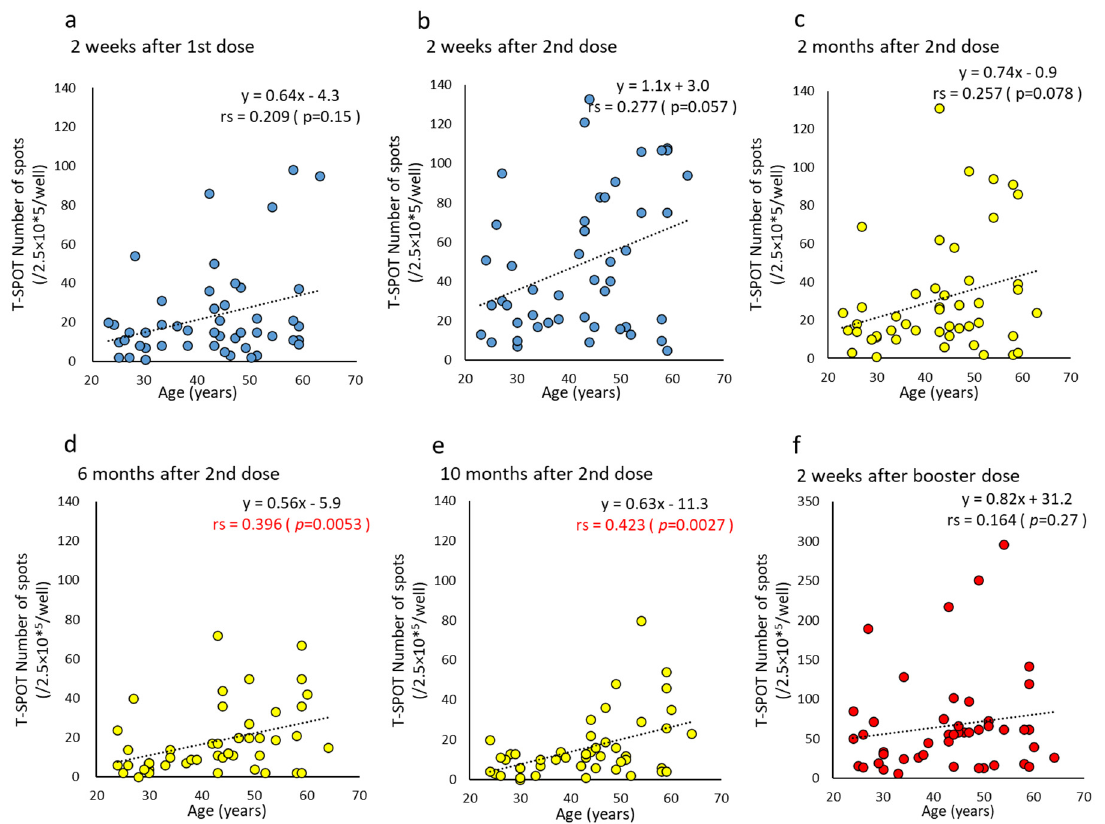
Figure 8. ( a – f ). Correlation at time points between age and T-SPOT after BNT162b2 vaccine doses. Parameter levels indicating T-SPOT of cell-mediated immunity against SARS-CoV-2 are plotted and compared according to age at each time point post-vaccine doses. Time points until two weeks after two doses are colored blue ( a , b ), from two months to 10 months after two doses are colored yellow ( c – e ), and two weeks after the booster dose are colored red ( f ). p -values were calculated using Spearman’s rank correlation test and significance was set at 0.01. Red values indicate a significant correlation (rs, Spearman’s rank correlation